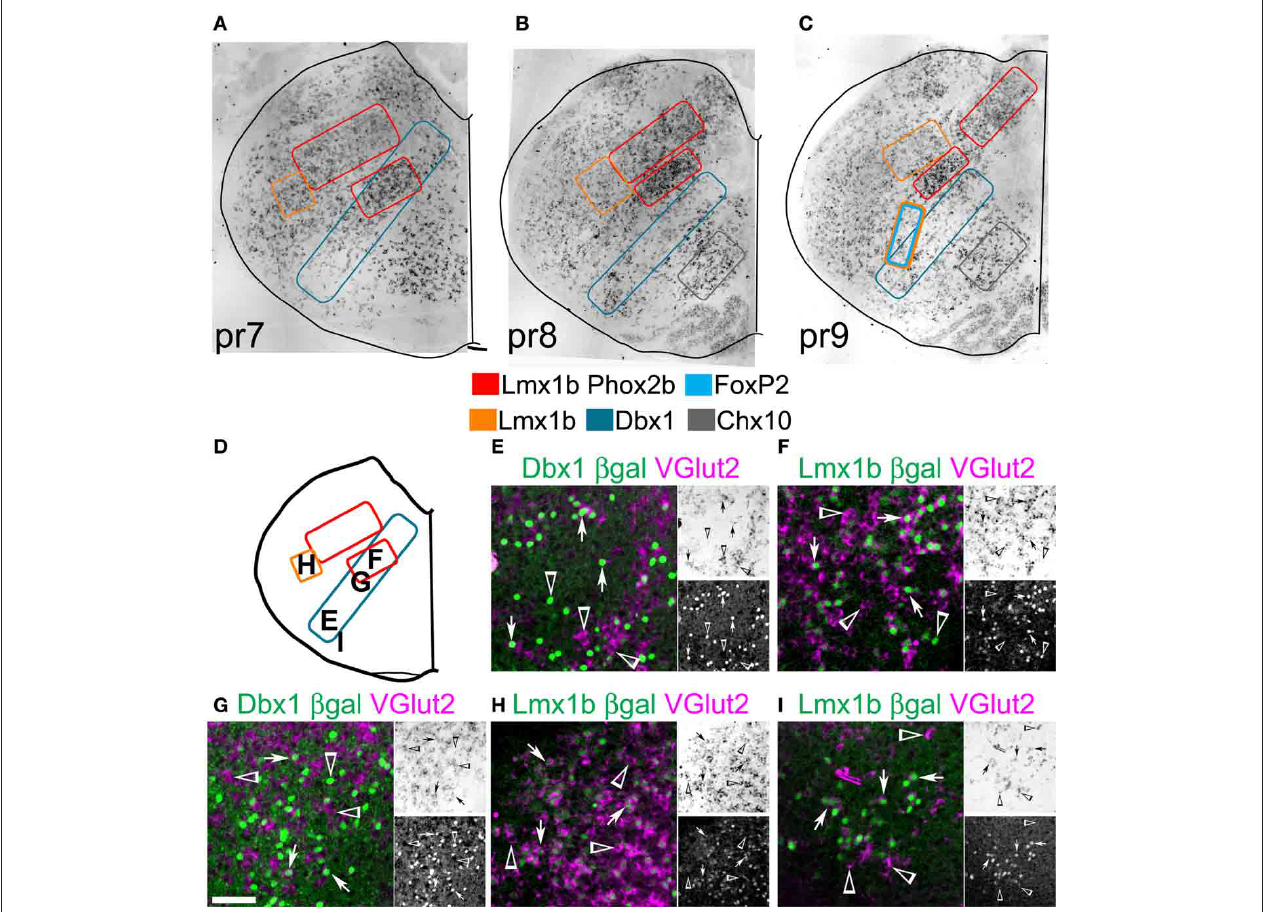
FIGURE 8 | Developmental origin of medullary reticular formation glutamatergic neurons. Brightfield in situ hybridization of VGlut2 mRNA from P0 mouse brain overlain with modified outlines from brain outlines from Figures 2C ( A , pr7), 2E ( B , pr8), and 2G ( C , pr9). Colored boxes indicate populations derived from distinct developmental lineages (see legend). (D) Schematic image modified from Figure 2C indicating